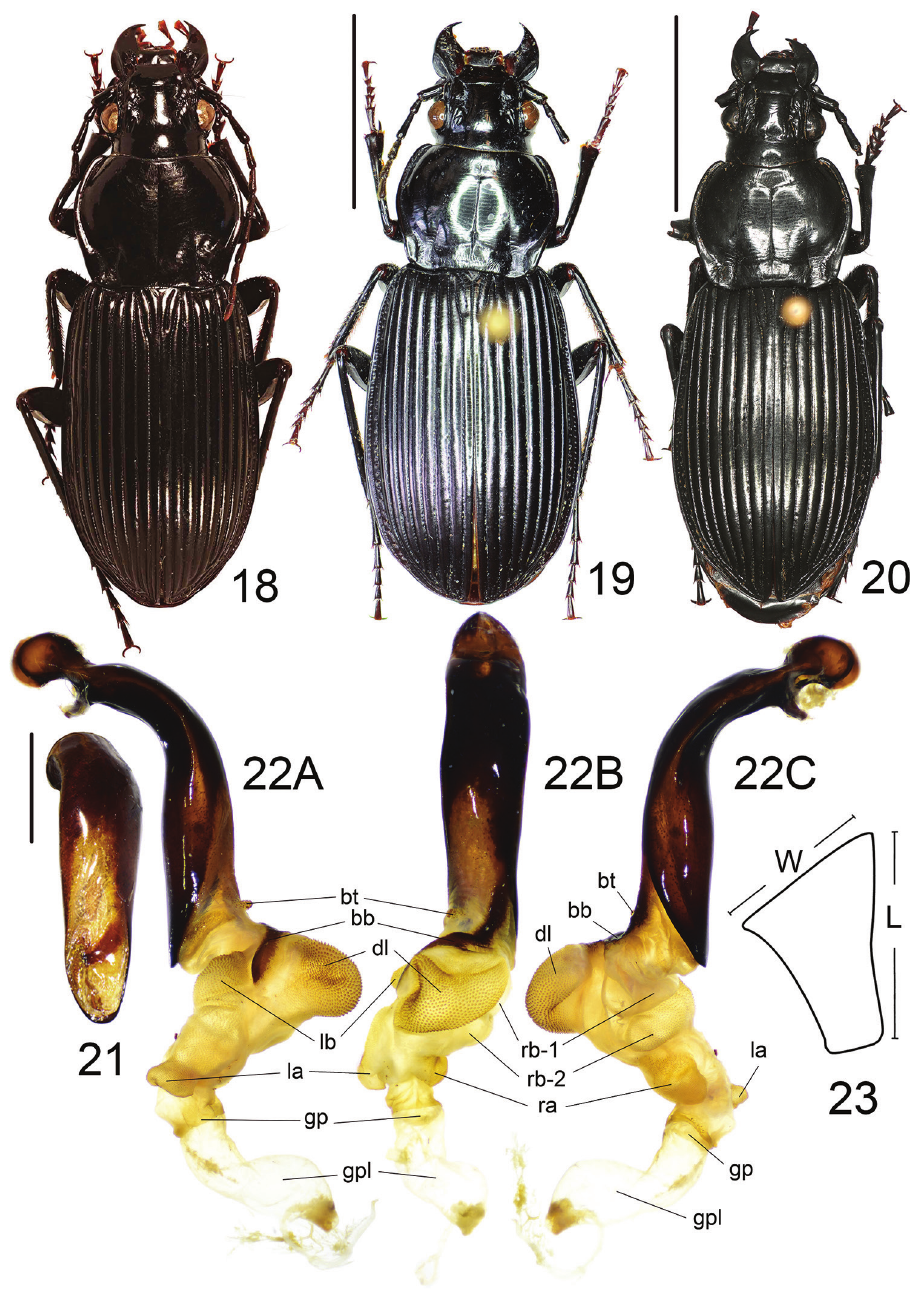
Figures 18–23. Lesticus solidus Roux & Shi. 18 holotype of L. dubius (male, Guangxi, MNHN) 19 holo- type of L. solidus (female, Guangxi, IZAS), scale bar: 10.0 mm 20 habitus of a male from Guangxi, scale bar: 10.0 mm 21 median lobe of aedeagus, dorsal view, scale bar: 2.0 mm 22 endophallus A left lateral view B dorsal view C right lateral view 23